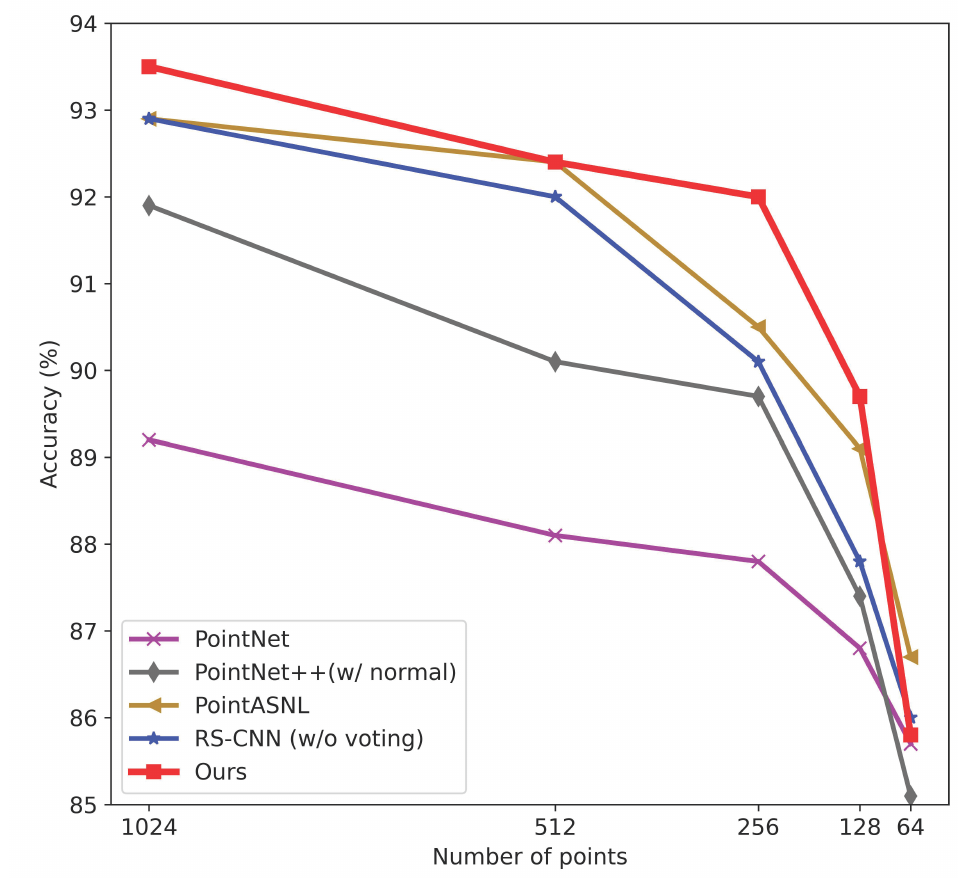
Figure 10. Accuracy at different densities. Table 7. Results of different sizes of local regions (%).